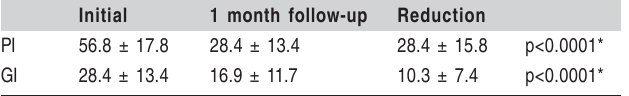
Table 1. Mean reduction (%) and standard deviation (SD) of PI and GI at baseline and 1 month follow-up.